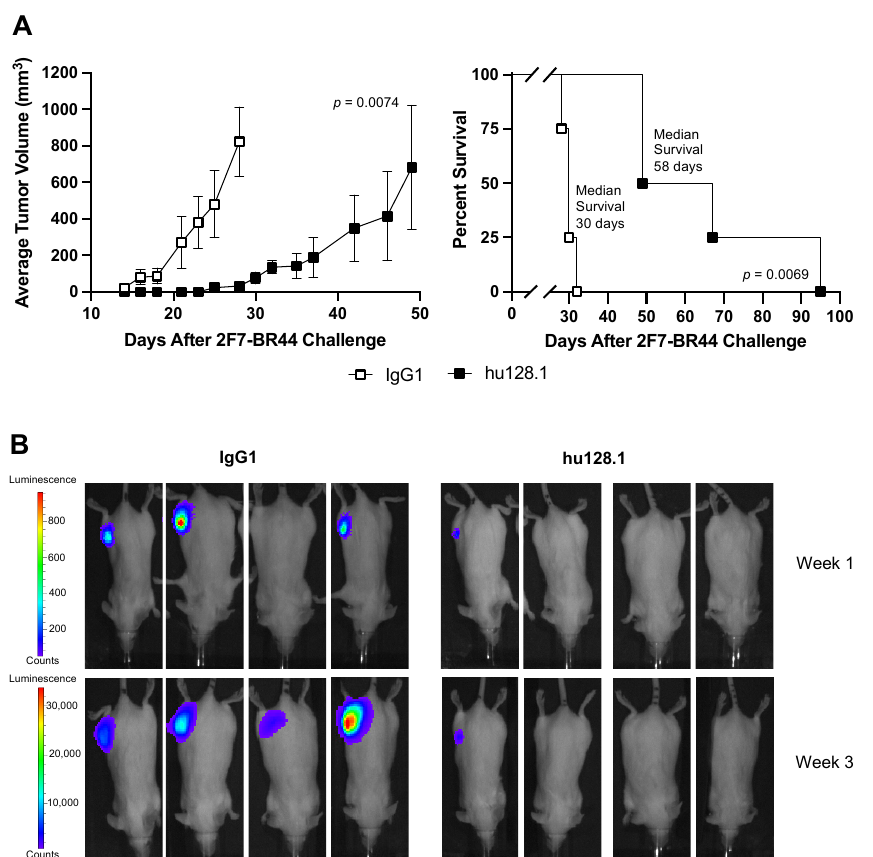
Figure 2. Bioluminescence imaging of mice in the local 2F7-BR44 model. SCID-Beige mice were challenged s.c with 2 × 10 6 2F7-BR44 cells in the right flank. Two days later mice were treated i.v. with 400 μ g isotype negative control antibody (IgG1) or hu128.1 ( n = 4 per group). ( A ) The tumor growth curves (left panel) and Kaplan–Meier survival plot (right panel) are shown. Tumor growth rates are shown as the average tumor volume with the SEM for each treatment group. Growth curves reflect the time when all animals in the treatment group were alive. Individual tumor growth curves are shown in Supplementary Figure S4. ( B ) Dorsal bioluminescence images for Weeks 1 and 3 after tumor challenge are shown for each mouse.